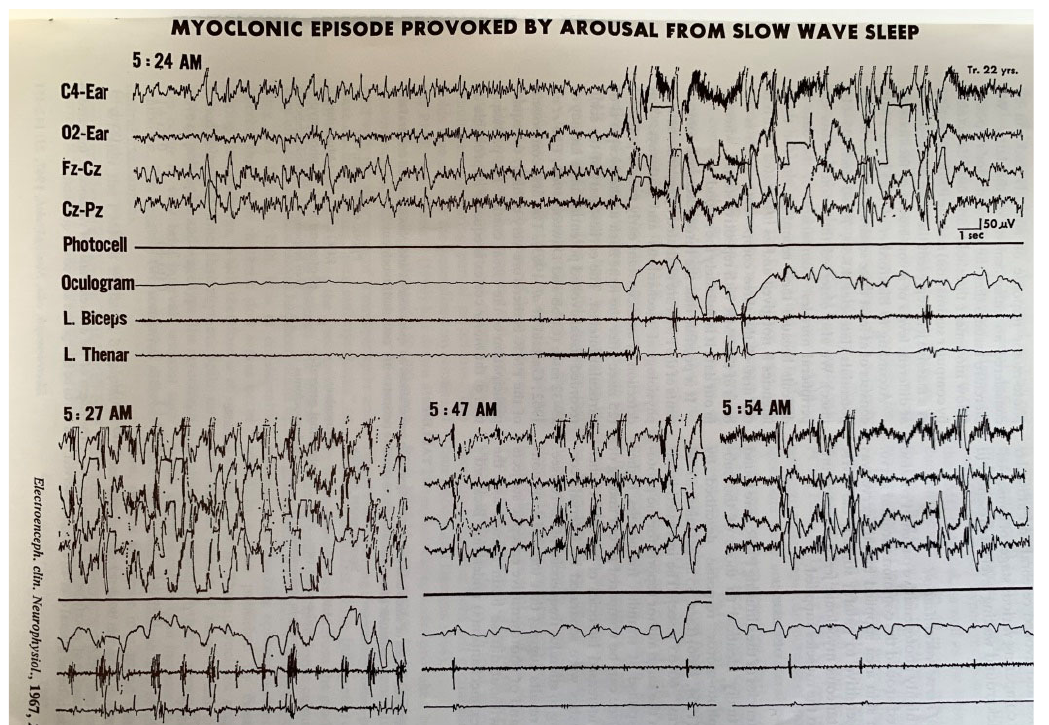
Figure 25. A generalized myoclonic seizure in a 22-year-old patient with Ramsay Hunt syndrome (photosensitive generalized epilepsy associated with cerebellar symptoms). He awakens at 5 h 24 min and the figure shows the continuation of the myoclonic epilepsy at different times after the awakening. The patient was awake during the seizure and shows eye movements due to looking around the room. (Reproduced with permission from Meier-Ewert, K. and Broughton, R: Photomyoclonic response of epileptic and nonepileptic subjects during wakefulness, sleep and arousal. Electroenceph. Clin. Neurophysiol. 23: 142–151, 1967, published by Elsevier Publishing). Clin. Transl. Neurosci. 2022 , 6 , x FOR PEER REVIEW